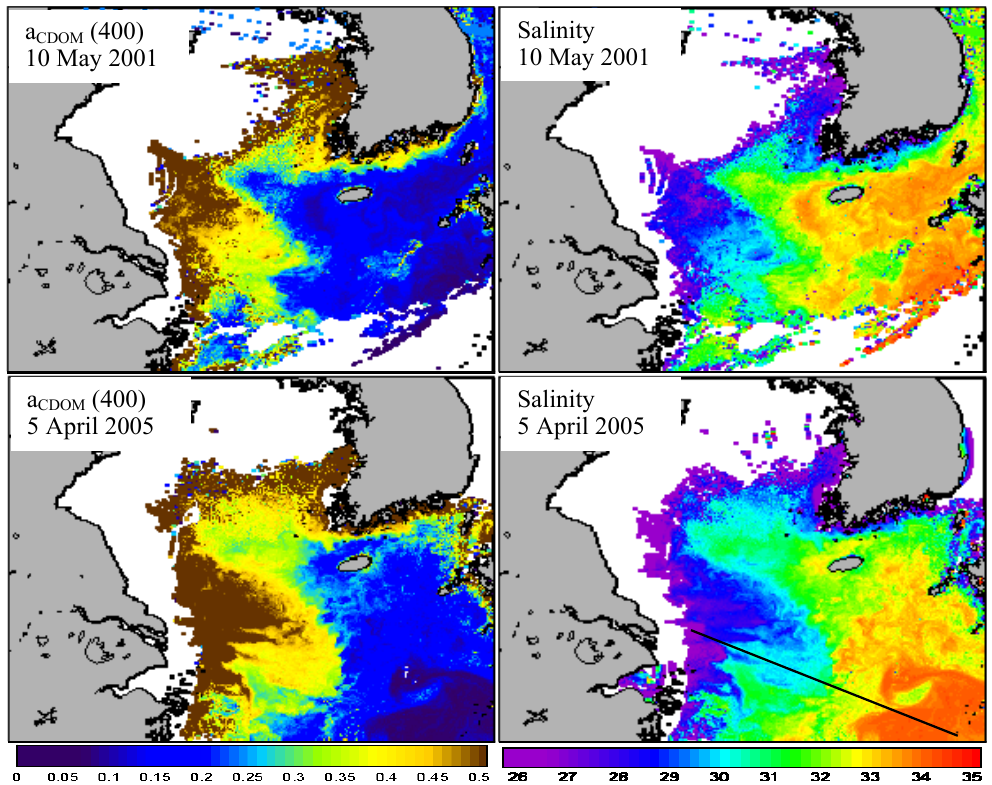
Fig. 9. SeaWiFS images of coloured dissolved organic matter ( a CDOM at 400nm (m − 1 )) and salinity (psu) for 10 May 2001 and 5 April 2005. Standard atmospheric correction (SAC) was applied to process these images.